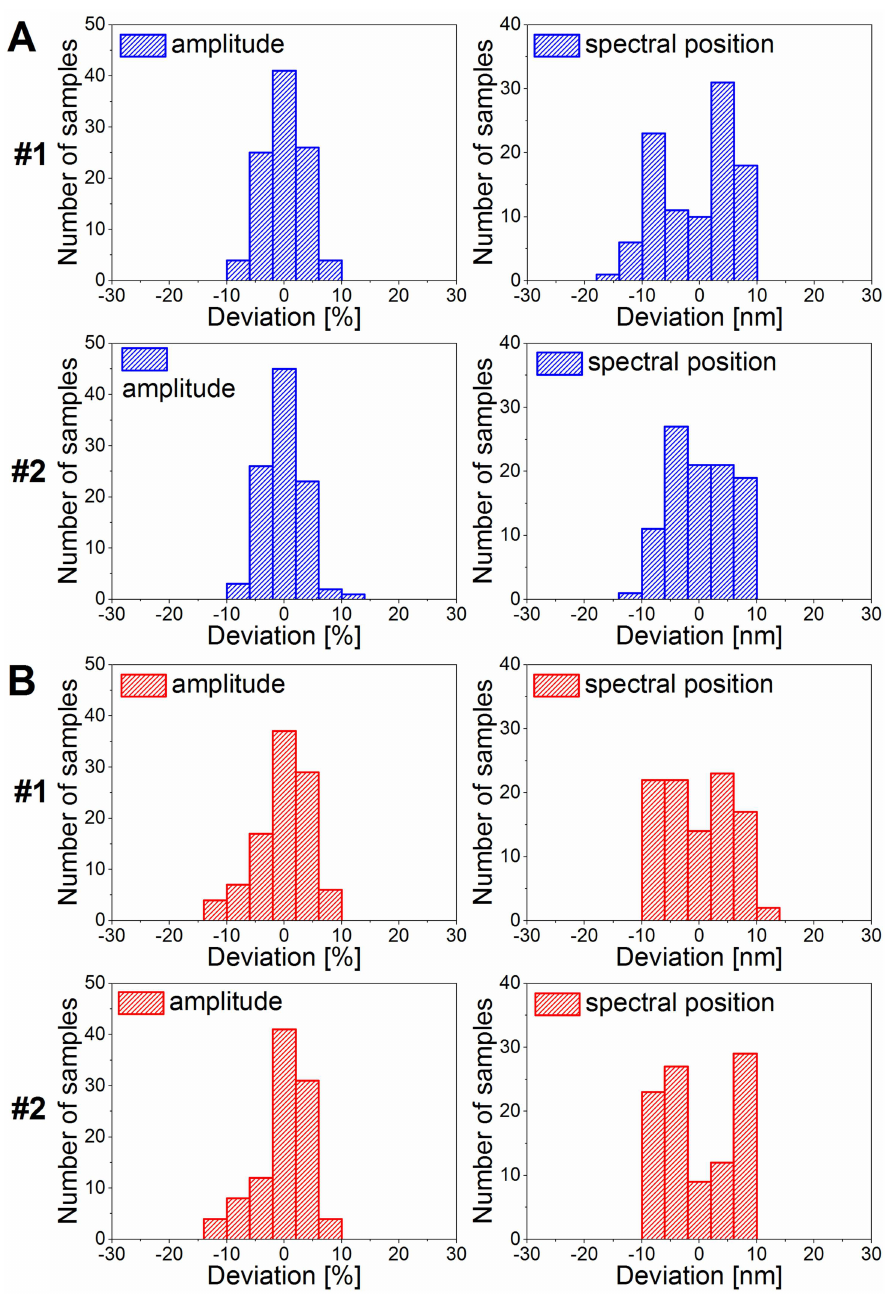
Fig 7. Histogram results of the spectral parameters measuredusing the integrating sphere by two operators. Both (A) Polyommatusicarus (blue) and (B) Plebejusargus (red) are shown. The histograms of the amplitudeand spectral position measuredby the different operatorsare similar (n = 100